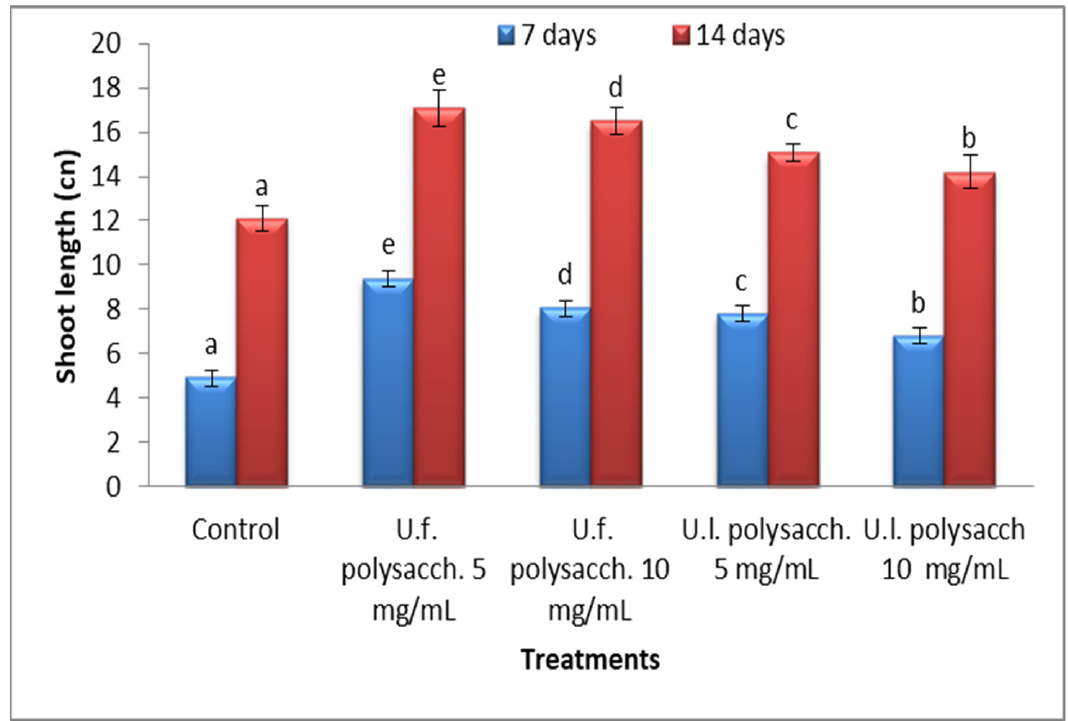
Figure 4. Effect of seed priming with different concentrations of soluble polysaccharides on the radical length of the seed germination of Zea mays. The bars represent the standard error. Different letters denote the significant values among the treatments (significant ≤ 0.05). U.f., Ulva fasciata; U.l., Ulva lactuca.